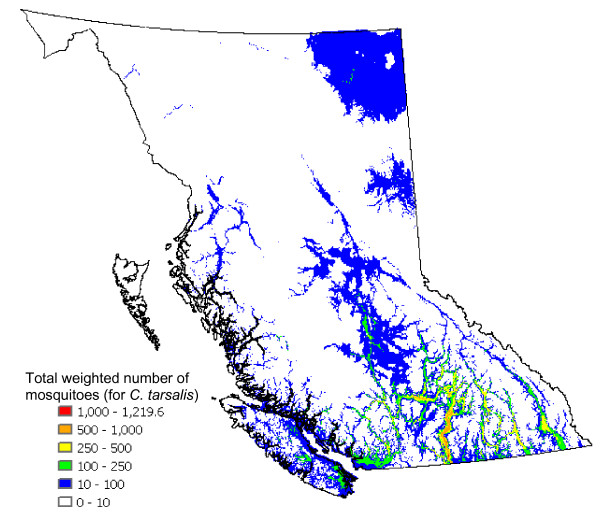
Annual total of weighed daily mosquito numbers per gird cell (C. tarsalis only). Weight: 1 for daily mean temperature (T) below 16°C, 2 for 16°C ≤ T<20°C, 3 for 20°C ≤ T<24°C, 4 for 24°C ≤ T<28°C, 5 for T ≥ 28°C (Weight is determined for each day and for each grid cell; see text for a discussion of the methodology used to determine the weights)